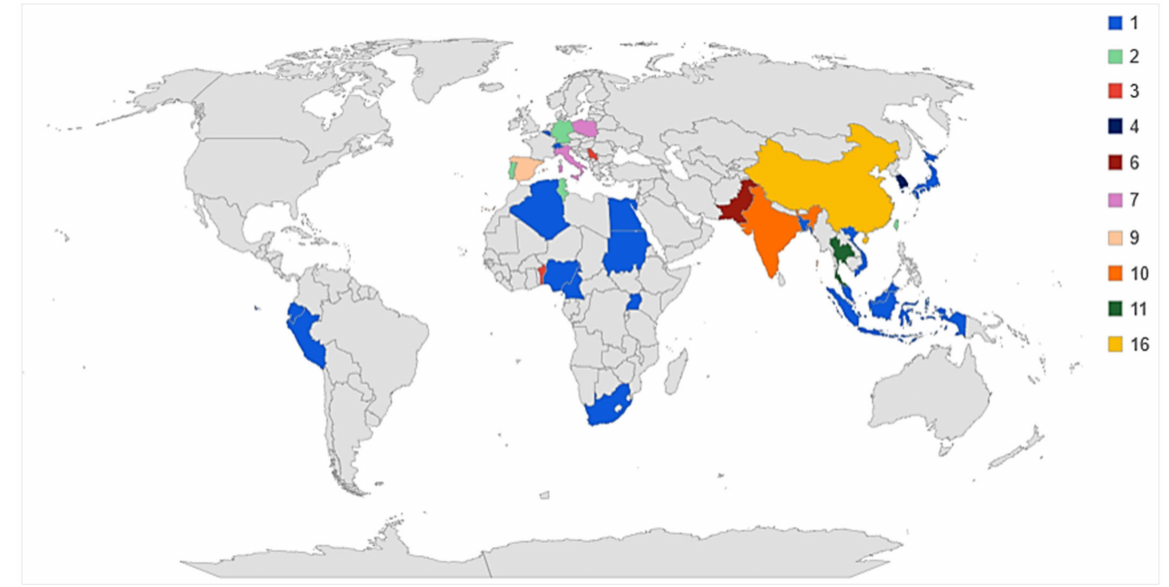
Figure 1. Territorial distribution and number of papers per